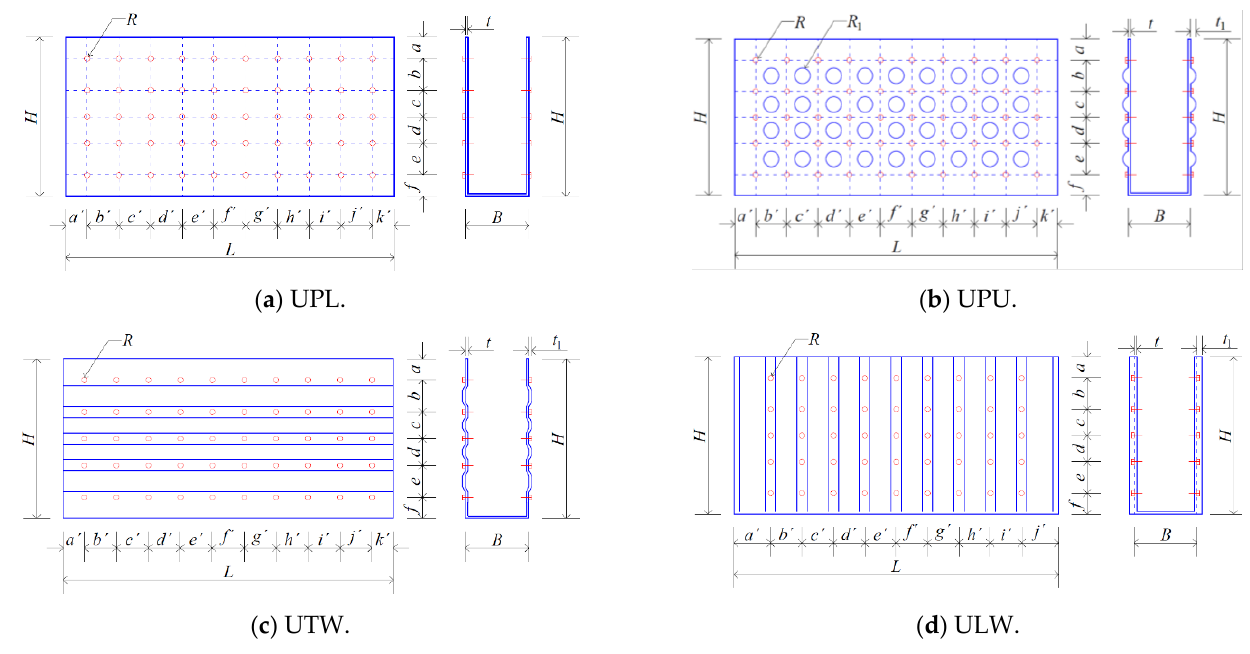
Figure 3. Dimensions of four U-shape connectors. Table 1. Dimensions of U-shape